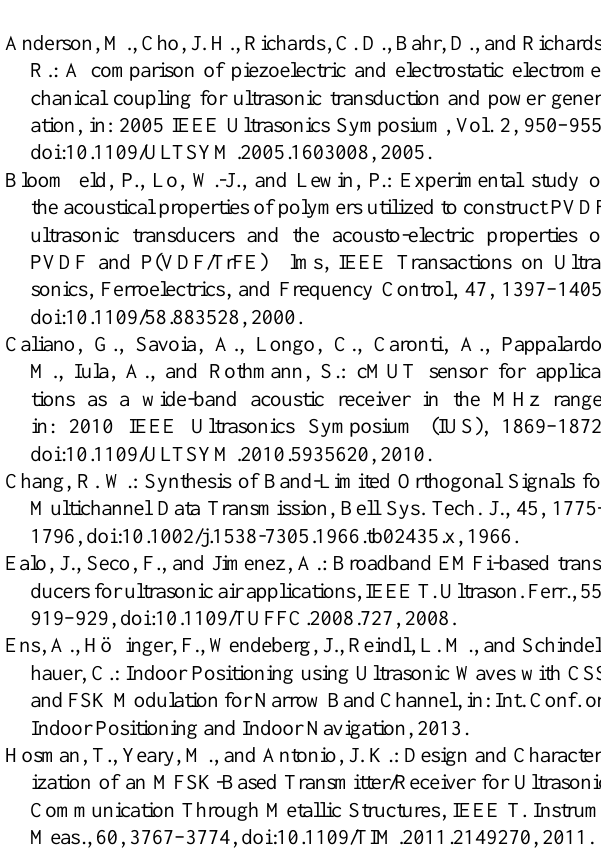
ning of the second symbol and settle down to (cid:56) f